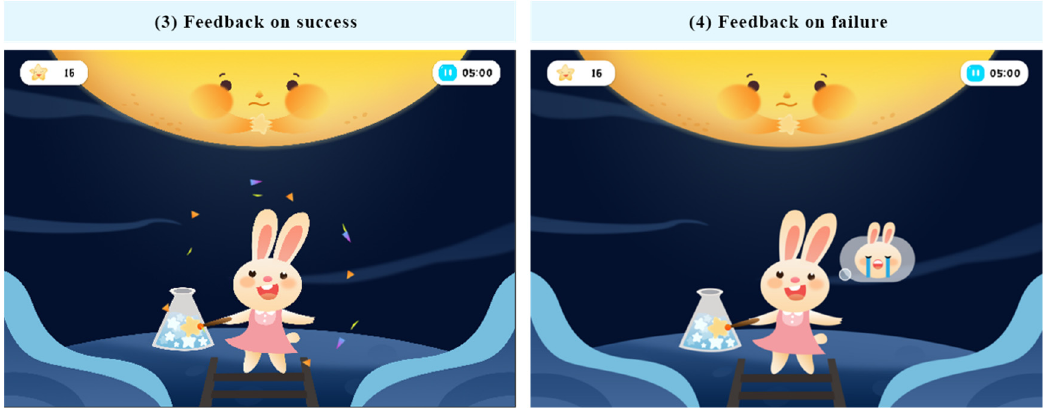
Figure 12. Examples of the training incentives and feedback (authors’ proposal).